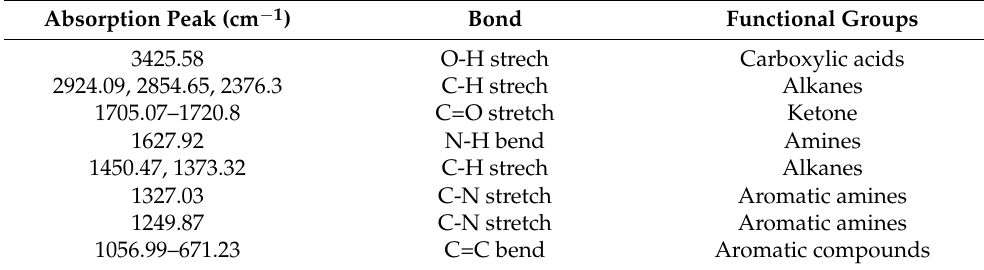
Table 6. FTIR absorbance values of the F3 column